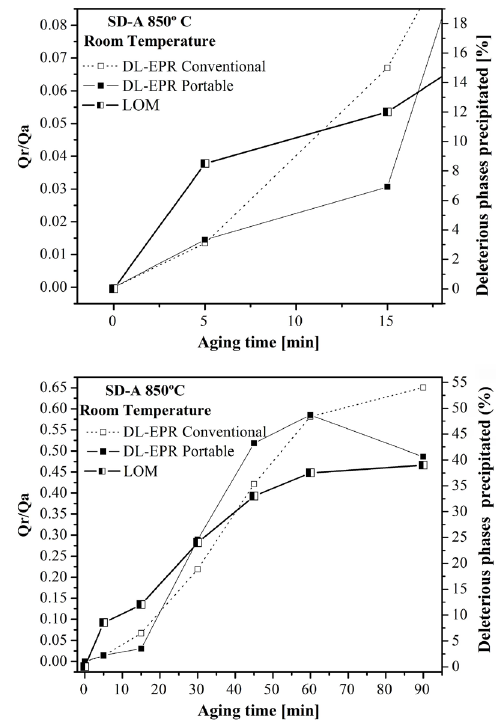
Figure 7. Qr/Qa ratios and deleterious phases precipitated percentage against aging time in SD-A samples aged at 850ºC till (a) 15 minutes and (b) 90 minutes.